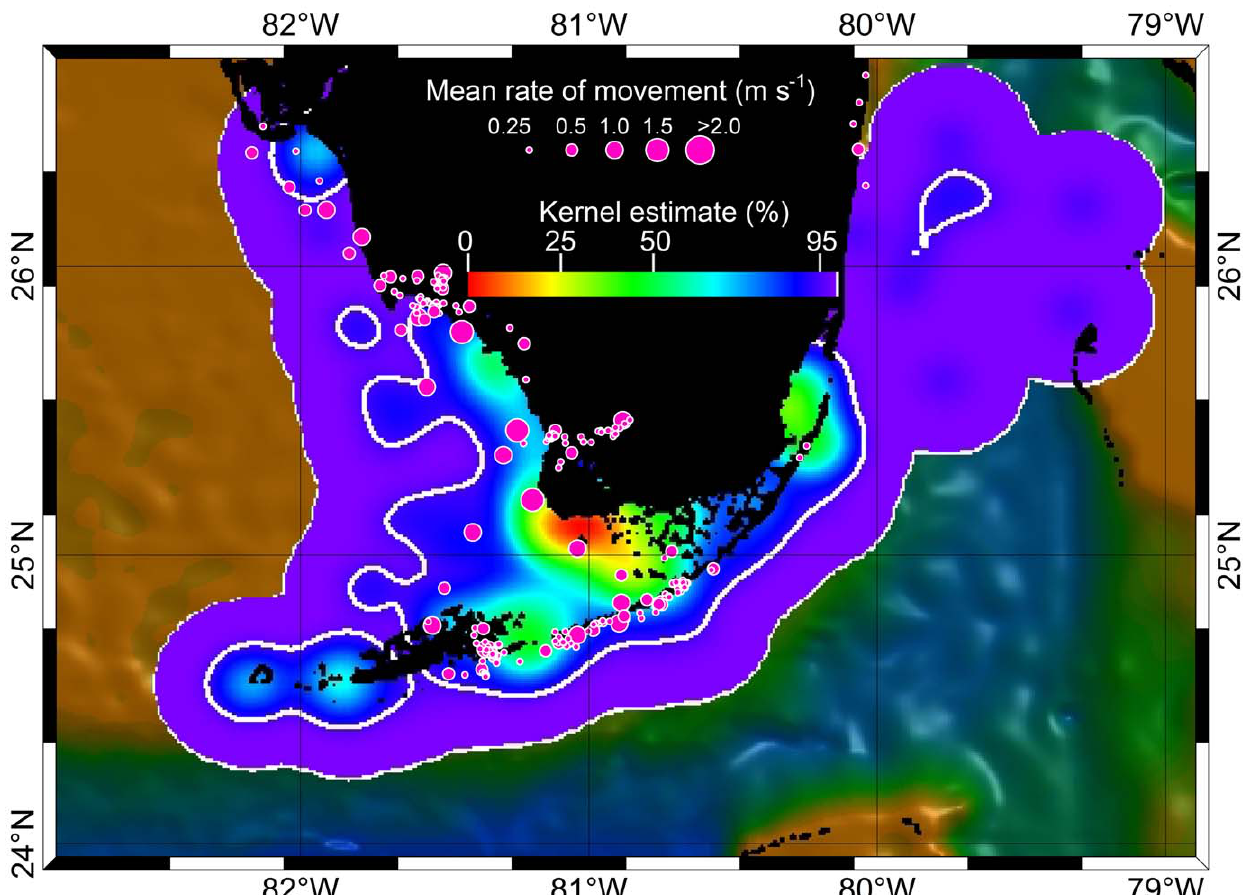
Figure 4. Predator-prey interactions between bull sharks and Atlantic tarpon in the southern Florida ecosystem. Colored contours indicate summarized accumulative kernel density values (from high density to low density) for 16 bull sharks and sizes of circles represent tarpon locations and rate of movement (m s 2 1 ). A tarpon (T182) released on 23 May, 2011, was likely attacked (red triangle) by a shark on 28 May in the core area of shark use (see text).